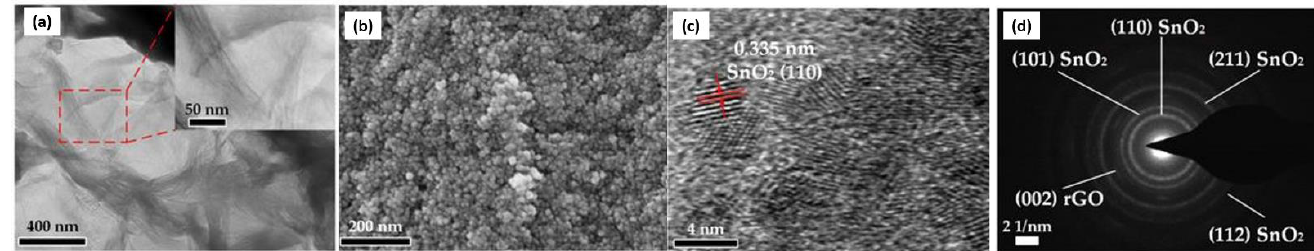
Figure 4. ( a ) TEM image of rGO with the inset HRTEM image of rGO at 50 nm, ( b ) SEM image of SnO 2 , ( c ) HRTEM image of rGO/SnO 2 prepared via the hydrothermal process at 180 °C and reaction time of 12 h, and ( d ) Selected Area Electron Diffraction (SAED) pattern of an rGO/SnO 2 nanocomposite. Reproduced from ref. [74].